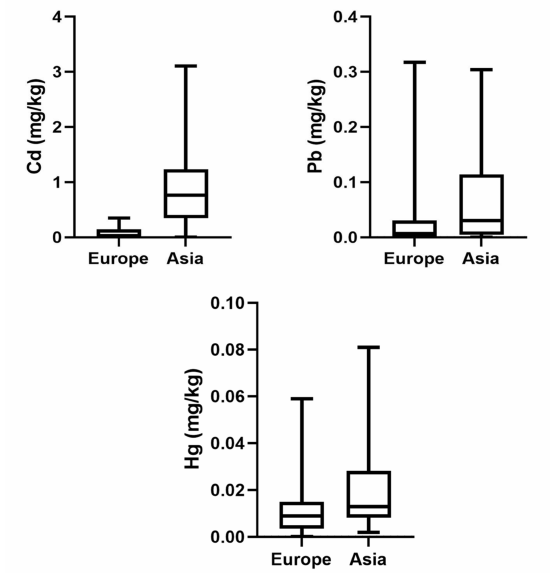
Figure 1. Comparison of the toxic metal content (Cd, Pb, Hg) between origins (Europe vs.